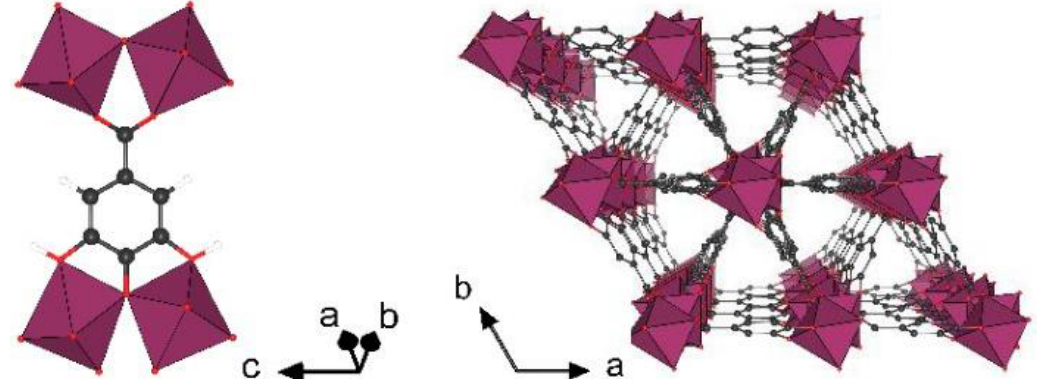
Figure 2. Crystal structure of gallate-based metal–organic frameworks (MOFs). Reprinted with permission [35].